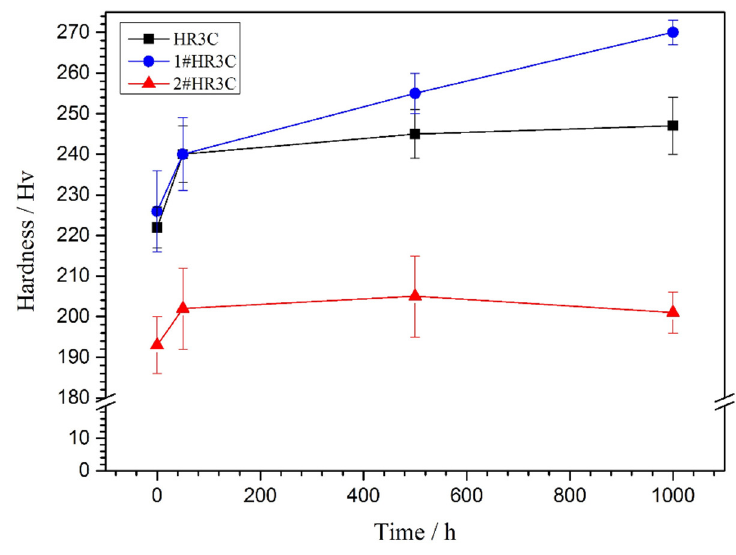
Figure 8. Variations of the microhardness of the three groups of HR3C alloys with the exposure time in a high-temperature water vapor environment at 650 °C.